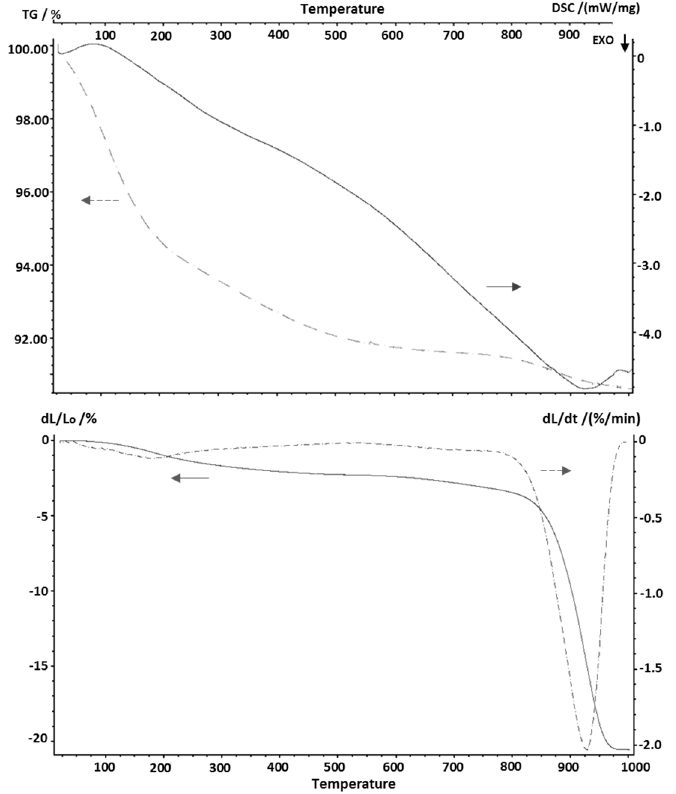
Figure 7. TG/DSC curves (top) and dilatometric curve with its derivative (bottom) for MKBM50.